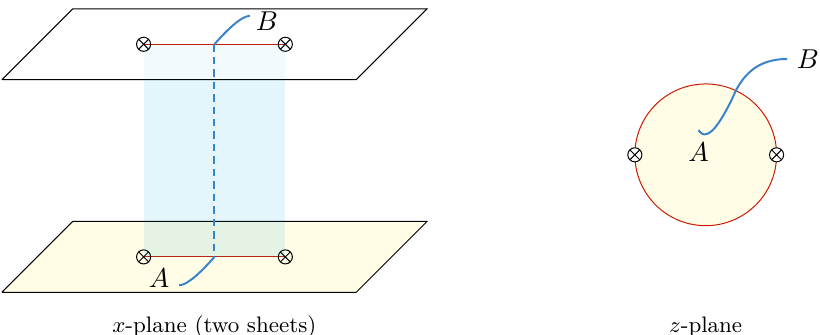
Figure 1 . Illustration of the spectral curve. Left : the two x -sheets connected by the red cut. The points A and B are in different sheets. Right : in the z -plane the circle is formed from two copies of the cut and separates the two sheets whose images are the outer/inner parts. In particular, the (image of the) point A is inside the